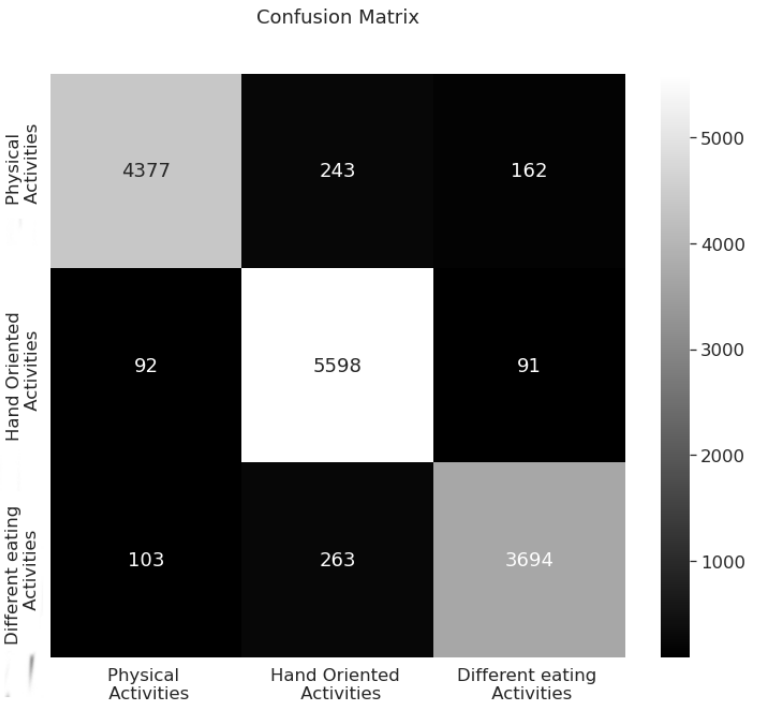
Figure 6. The confusion matrix for activity detection. The better the model, the values outside the main diagonal are lower compared to the ones on the main diagonal.